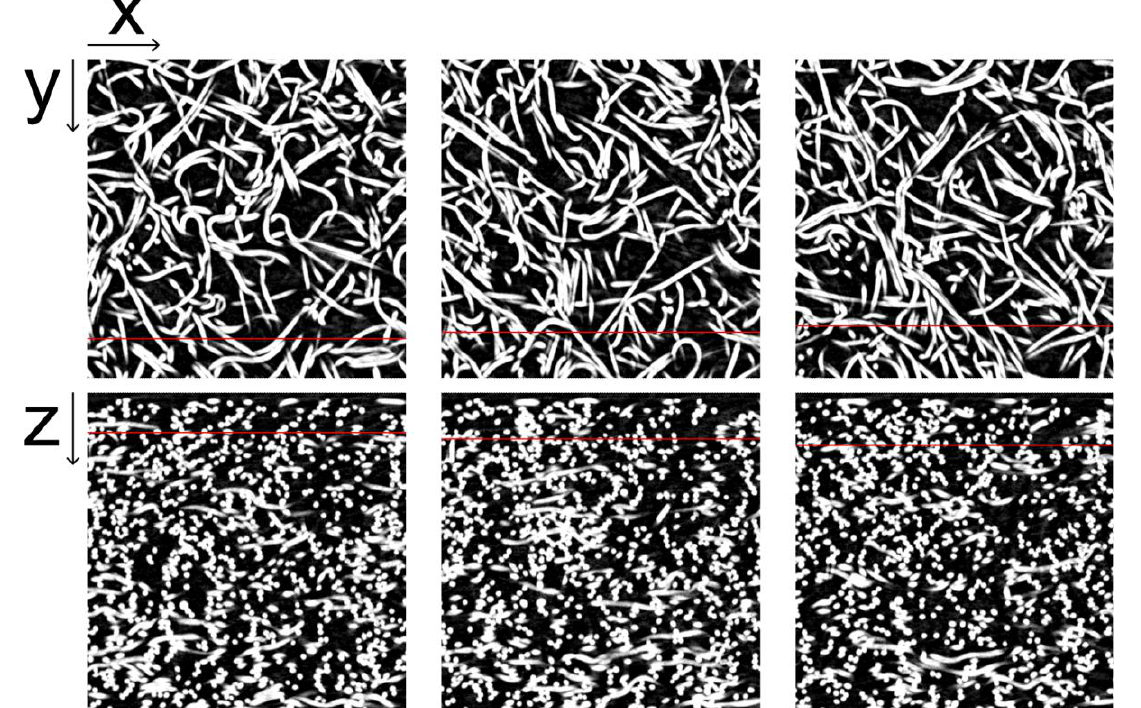
Figure 7. Cross-sectional X-ray computed tomography images of the 8-ply laminated product. The upper images are the xy-plane images cut by the red lines in the lower images. The lower images are the xz-plane images cut by the red lines in the upper images. The left, center, and right cut positions are all shifted by 10 μm.